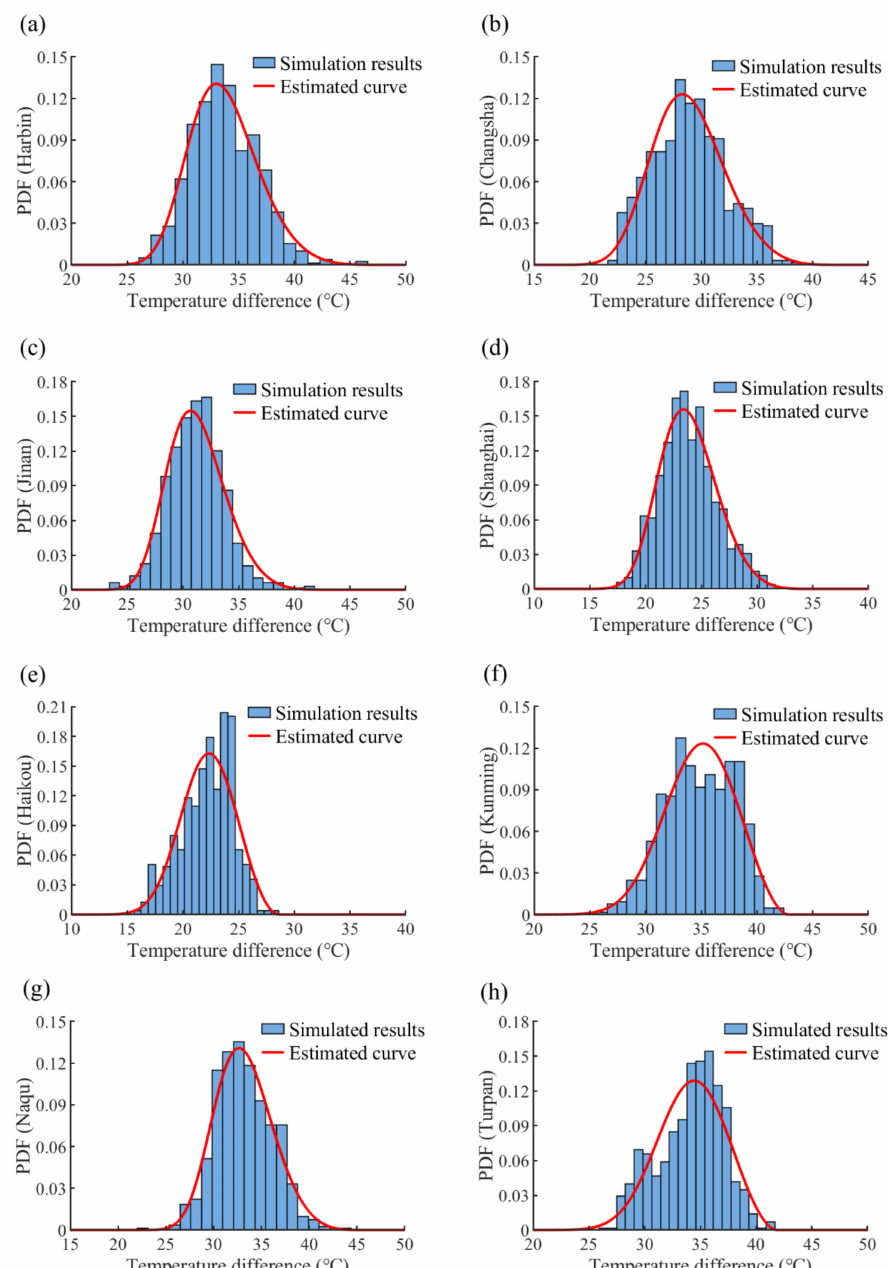
Figure 15. Frequency histogram and fitted PDF curves regarding different cities: ( a ) Harbin; ( b ) Changsha; ( c ) Jinan; ( d ) Shanghai; ( e ) Haikou; ( f ) Kunming; ( g ) Naqu; and ( h )